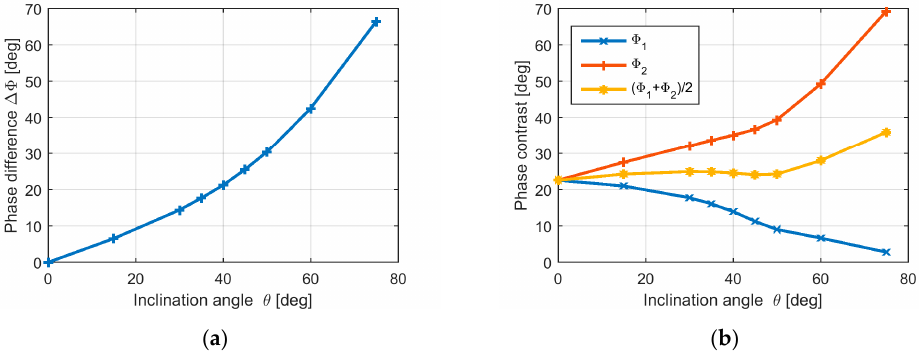
Figure 15. Phase difference ( a ) and phase contrasts ( b ) for an asymmetrical phase distribution depending on the inclination angle of the crack with a 1 mm depth. For the definition of the displayed values, see Figure 14a.